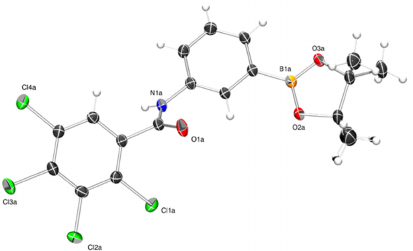
Figure 2. ORTEP plot of compound meta 5 (30% ellipsoids).